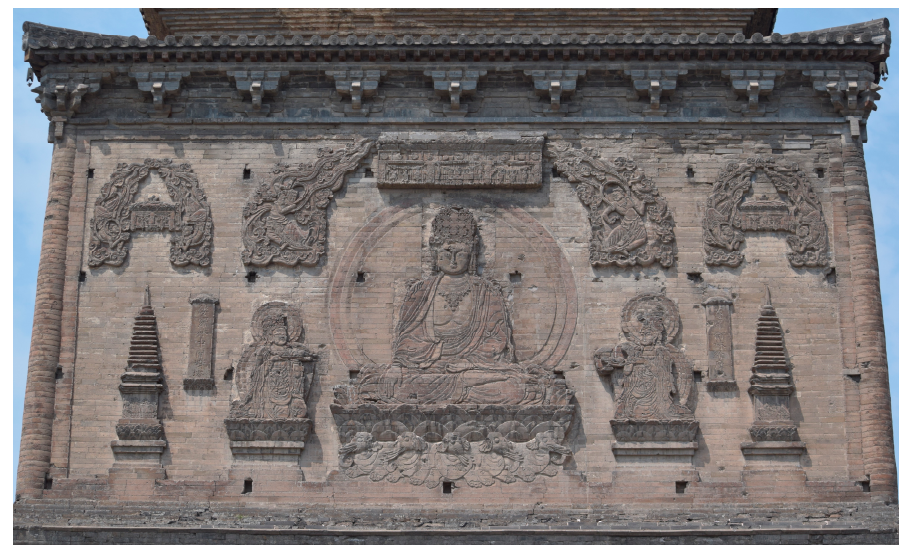
Figure 3. The central Buddha and attending bodhisattvas, east wall of Chaoyang North Pagoda, Chaoyang, Liaoning Province, China. Liao dynasty, 1043–1044 [©Photograph by Youn-mi Kim, 2014].